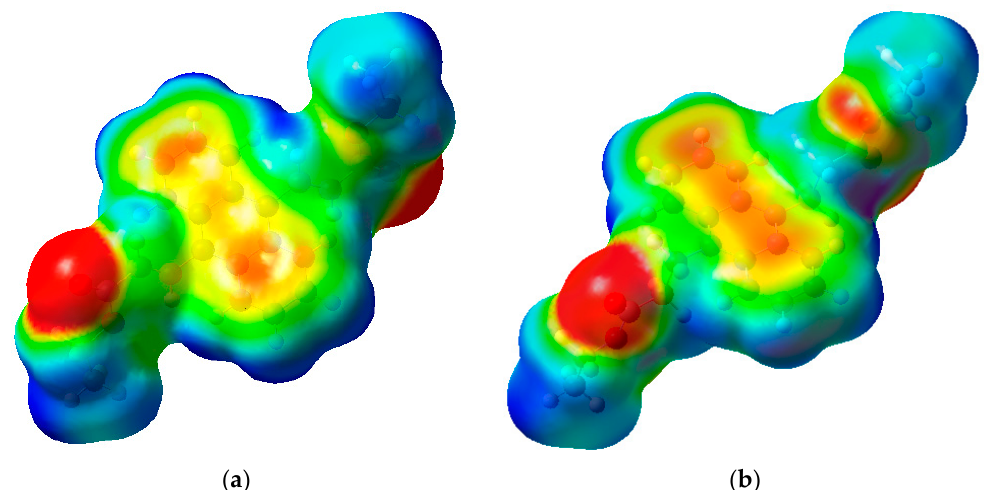
Figure 12. MEP surface at the ρ (r) = 4.0 × 10 − 4 electrons/bohr contour of the total SCF electronic density for the ( a ) DADB and ( b ) DEADP molecules, using M06-2X/6-311++G(2d,2p) level of theory.